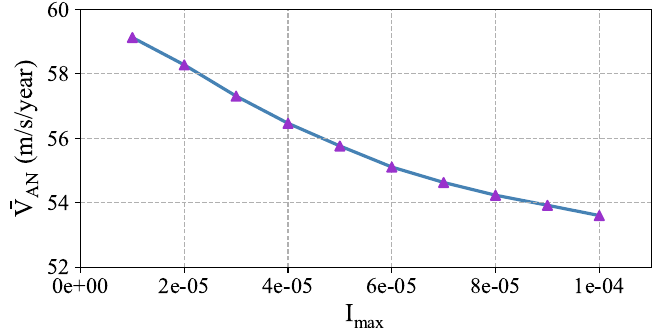
Figure 14. The results of Monte Carlo simulations for ∆ i max . Table 1. The values of β max , β min , α max , α min in different levels of constraints. Level